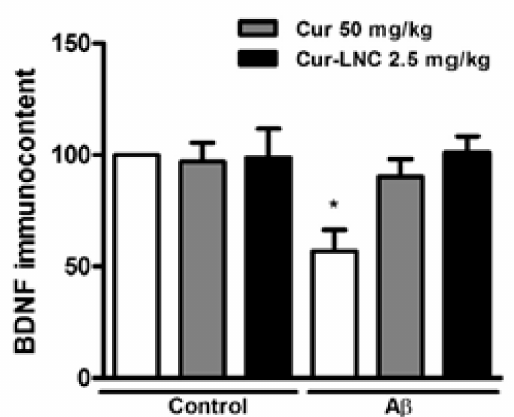
Figure 2. BDNF immunocontent after application of A β (1-42) and curcumin. * Significantly different from all other study groups ( p < 0.05) Significantly different from all other study groups ( p < 0.05) [66]. Reproduced from [37] with the permission from